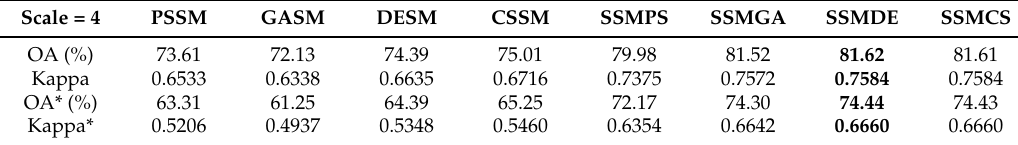
Table 2. Comparison of the land-cover change detection performances of the sub-pixel mapping algorithms in Experiment 1 (change/no change).